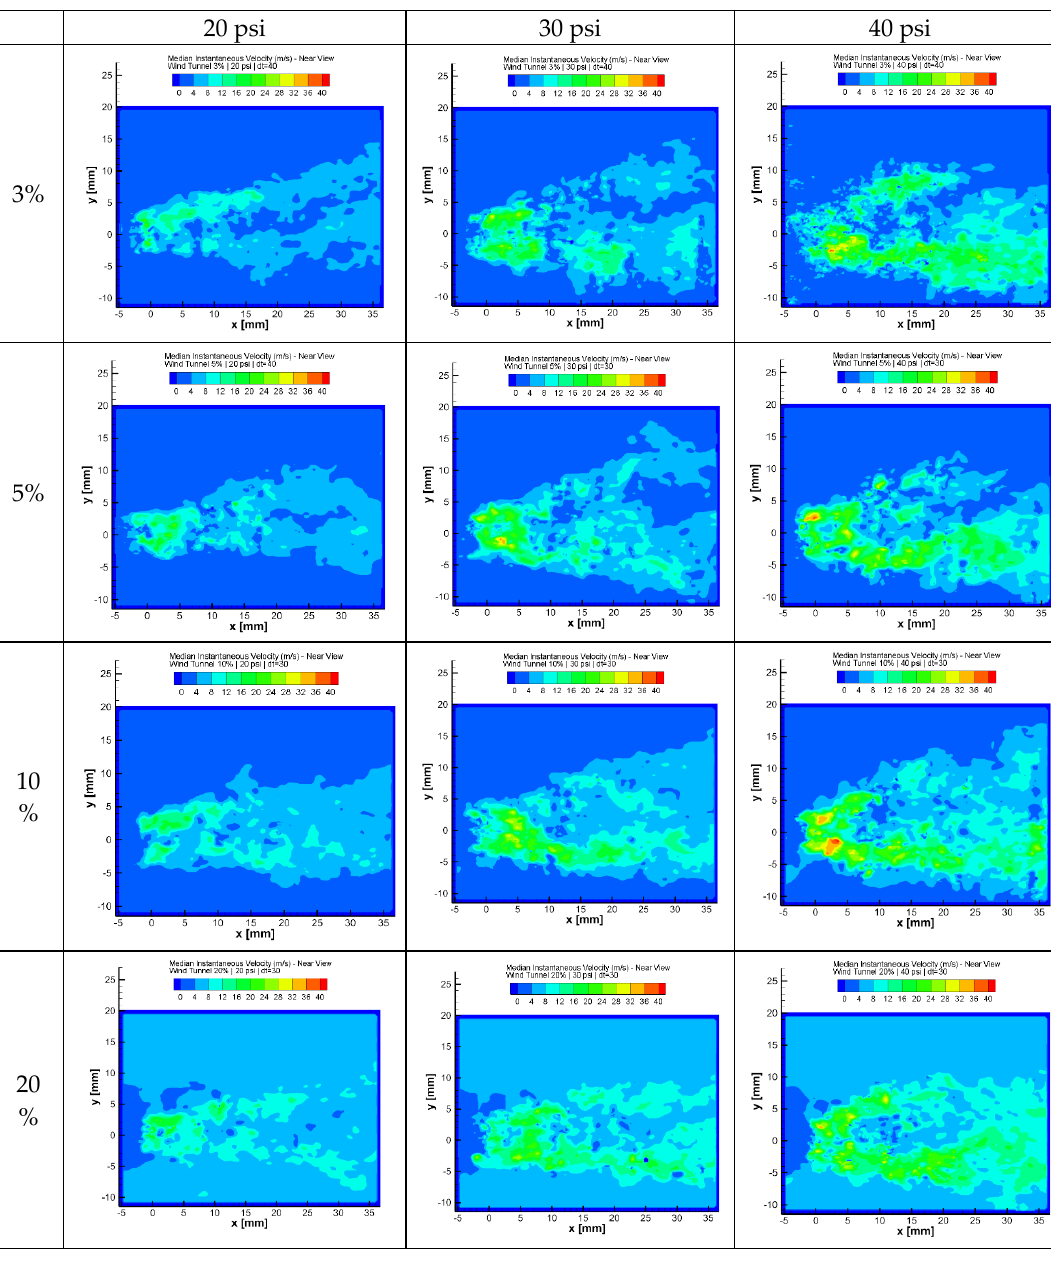
Figure 7. Instantaneous vortex-tube flow at near region. Data at 3%, 5%, 10%, and 20% freestream wind tunnel speed settings (rows) for three different vortex tube pressures (columns).